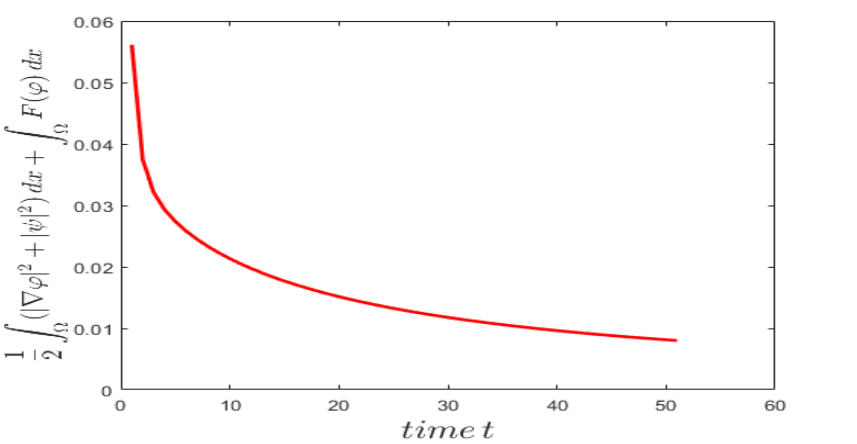
Figure 20. The total energy defined in (3) of the